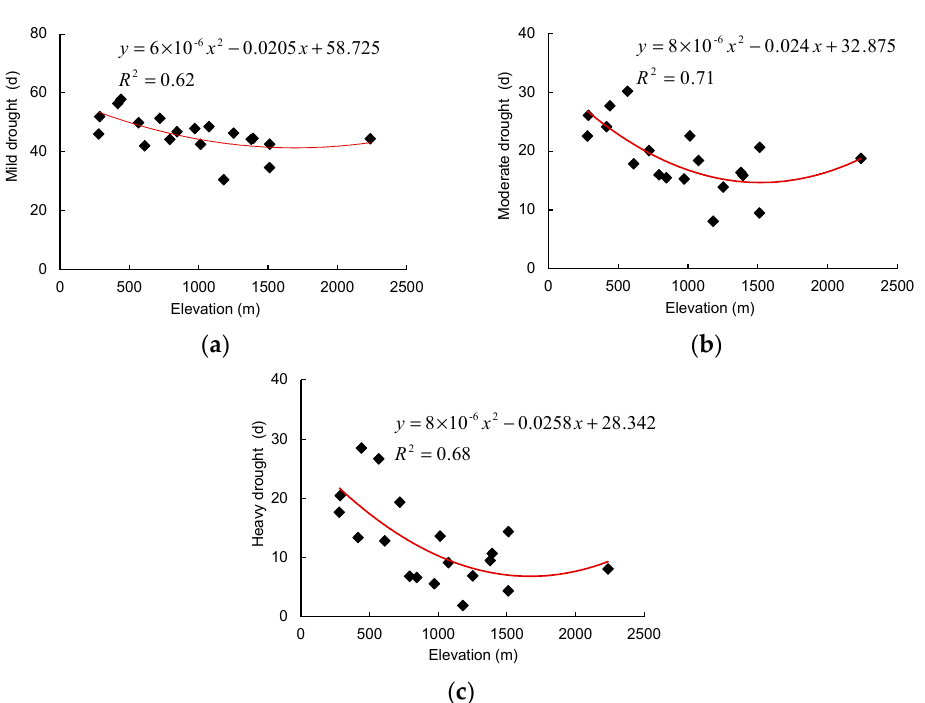
Figure 13. Relationship between ( a ) mild drought, ( b ) moderate drought, ( c ) heavy drought and elevation.